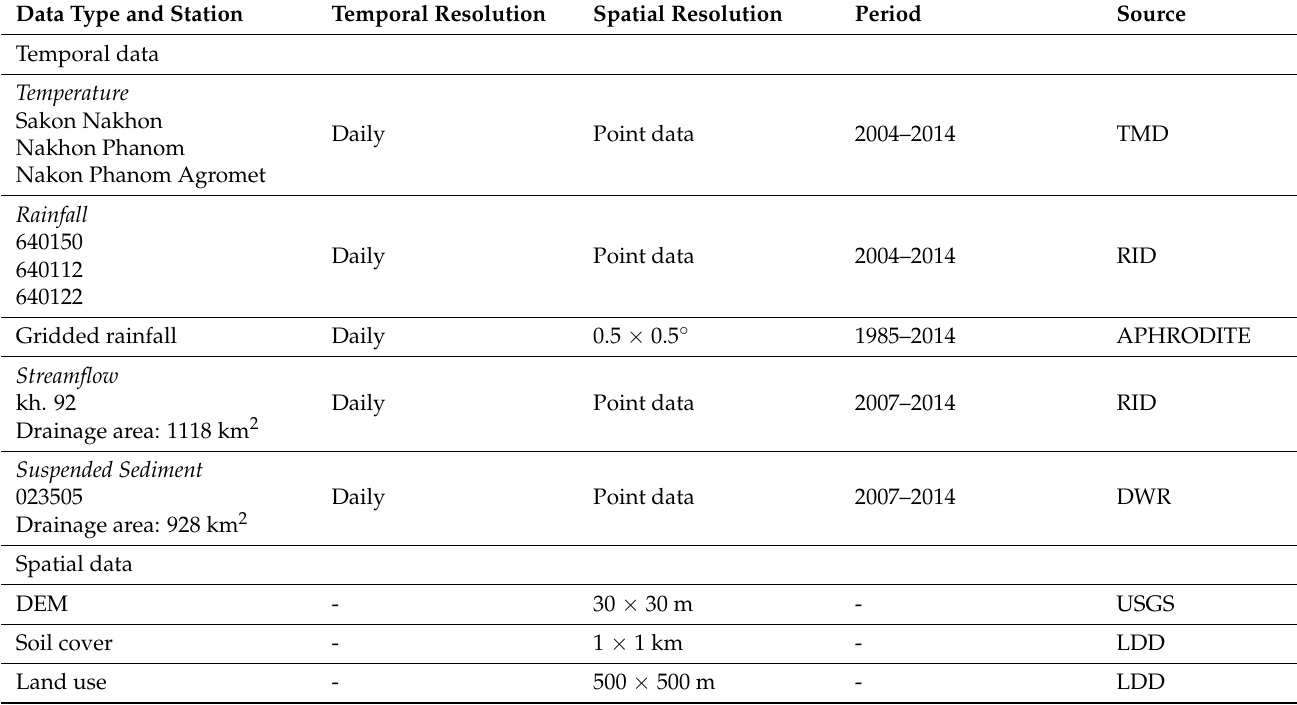
Table 1. Description of temporal and spatial data used in this